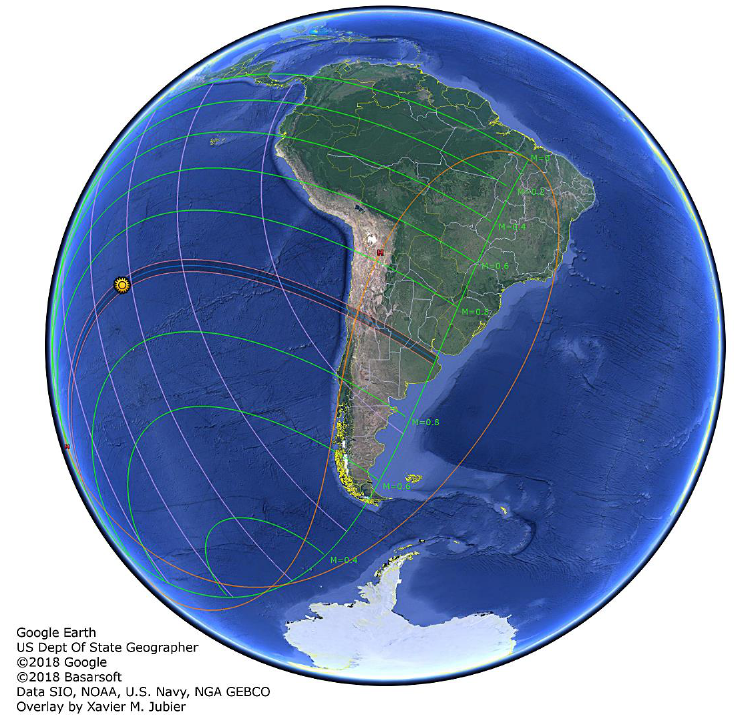
Figure 1. 2019 solar eclipse trajectory, indicating magnitude bands (green lines) and umbra zone (dark blue area). Figure generated using Google Earth (2019) and an eclipse data overlay elaborated by [1].